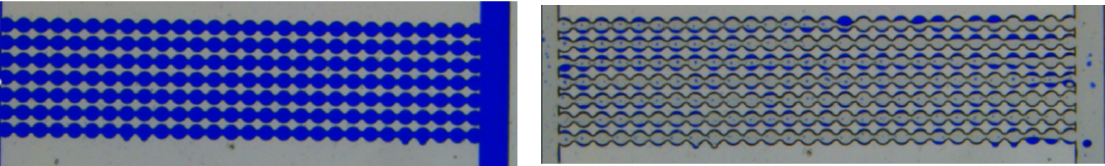
Figure 9. Liquid retention of gas flooding in homogeneous model.